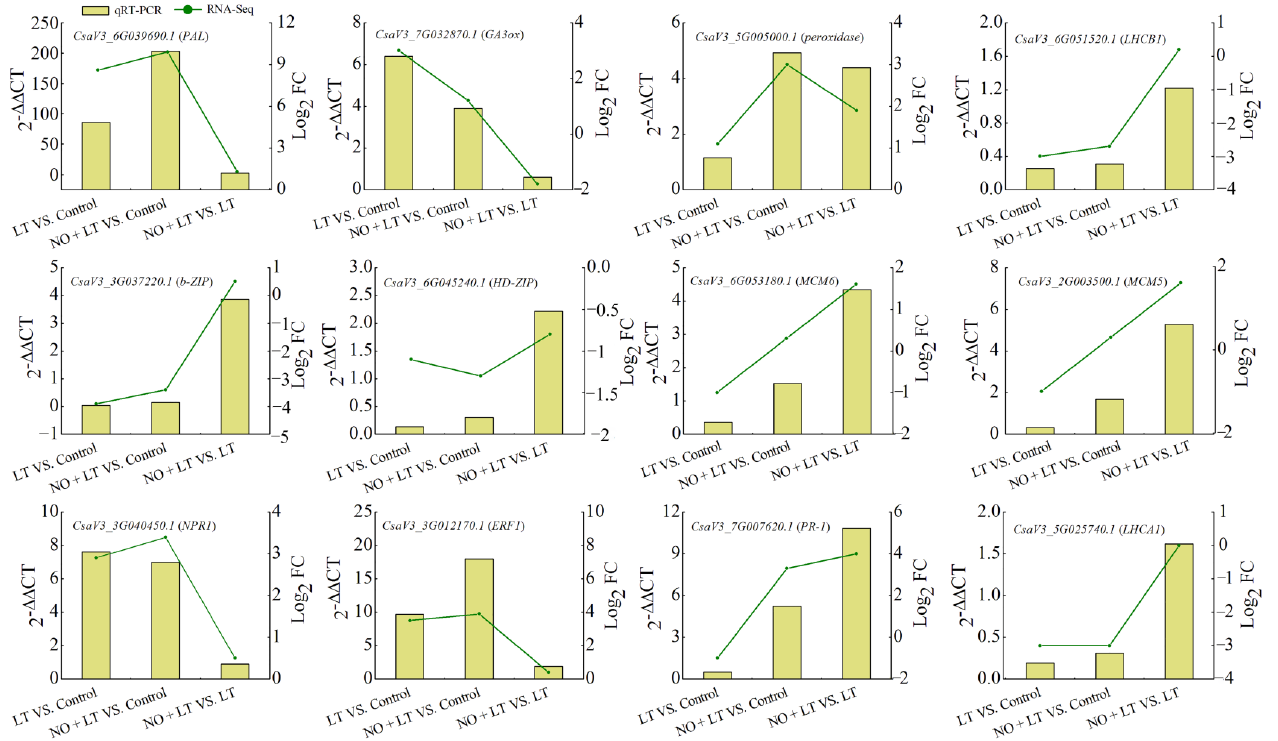
Figure 7. Validation of 12 selected genes by qRT-PCR. The mRNA expression levels were calculated by 2 − △△ CT , and the Actin gene was used for normalizing the expression level. The ratio of relative expression in each combination is shown in the figure. The accumulated transcripts of the candidate genes in Log 2 (Fold Change) were obtained from the RNA-seq data.